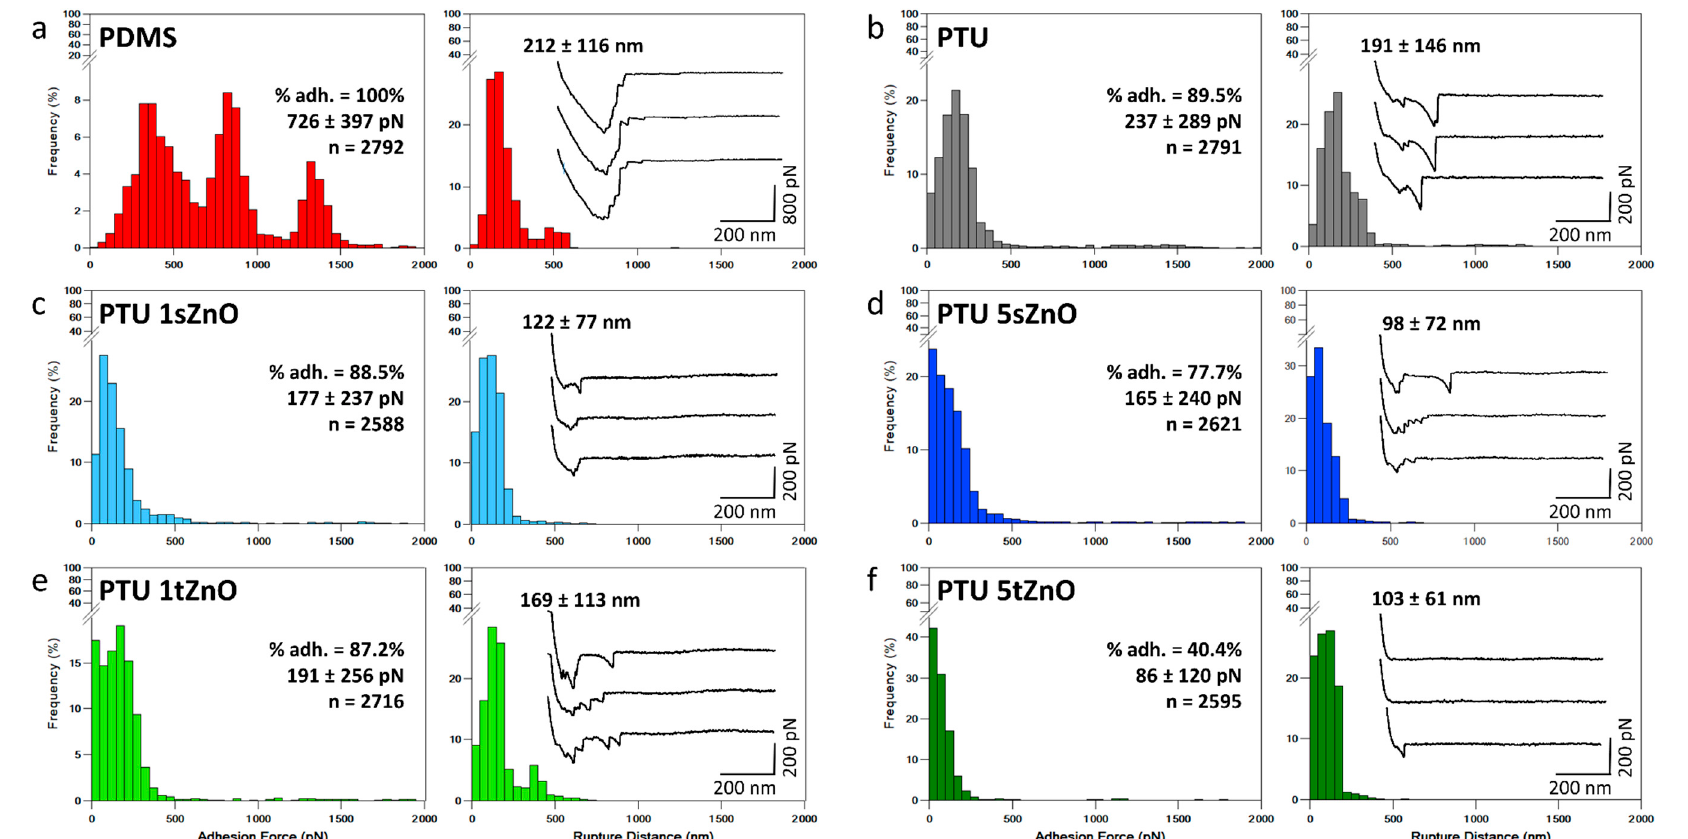
Figure 1. Single-cell force spectroscopy to probe the interactions between S. aureus and material surfaces. Adhesion force histogram and corresponding rupture distance histogram obtained for seven cells interacting with ( a ) PDMS, ( b ) PTU, ( c ) PTU containing 1 wt.% of s-ZnO, ( d ) PTU containing 5 wt.% of s-ZnO, ( e ) PTU containing 1 wt.% of t-ZnO and ( f ) PTU containing 5 wt.% of s-ZnO. Insets in rupture distance histograms show representative force curves obtained in each case. % adh. is the % of force curves presenting adhesive events. Data were recorded using a set-point of 0.25 nN. 3.3 PTU/ZnO composites are also efficient anti-adhesive surfaces against yeast cells.